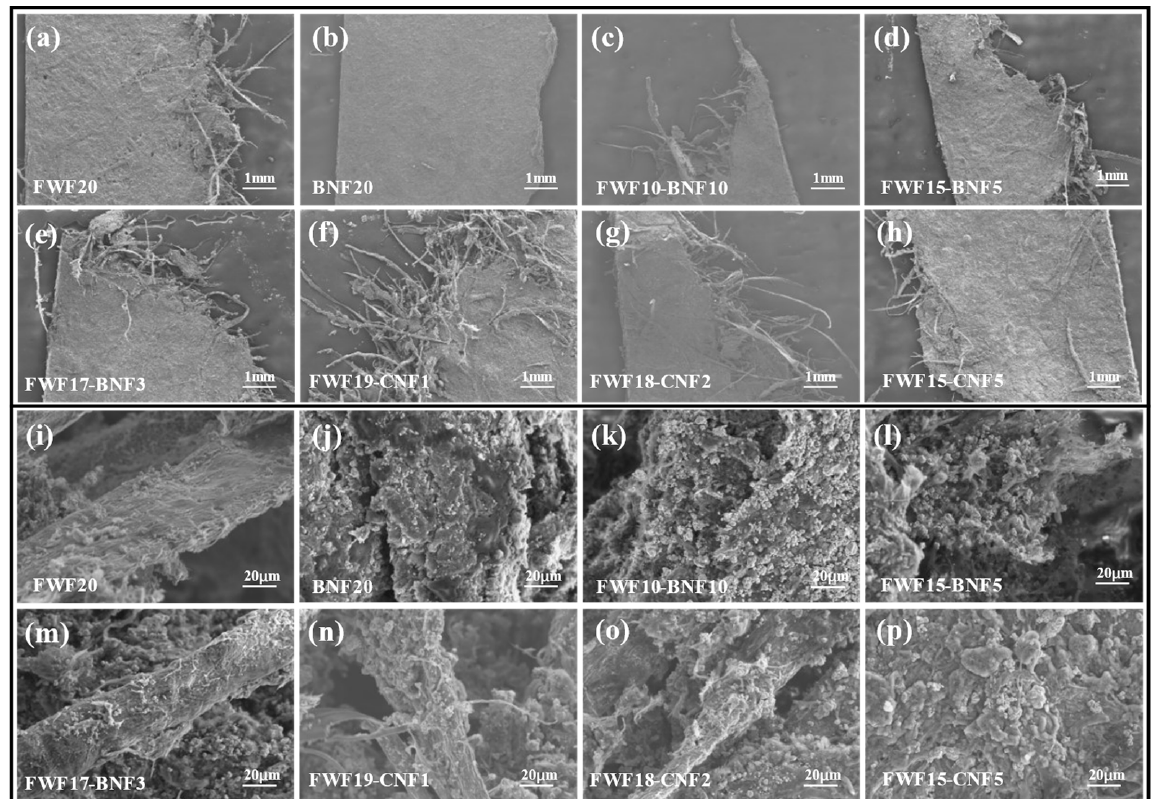
Figure 4. ( a – h ) are SEM images of paper-based electrodes with different nanofiber content at 50 times. ( i – p ) are SEM images of paper-based electrodes with different nanofiber content at 2 k times.